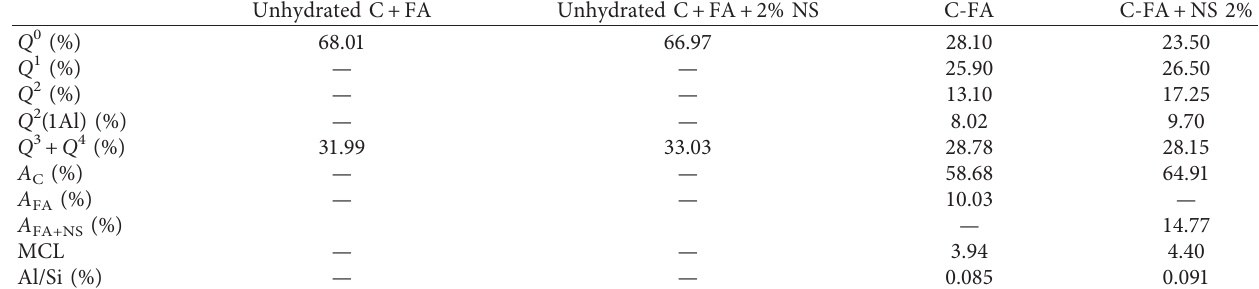
Table 6: Deconvolution results of the paste samples hydrated at 28d.